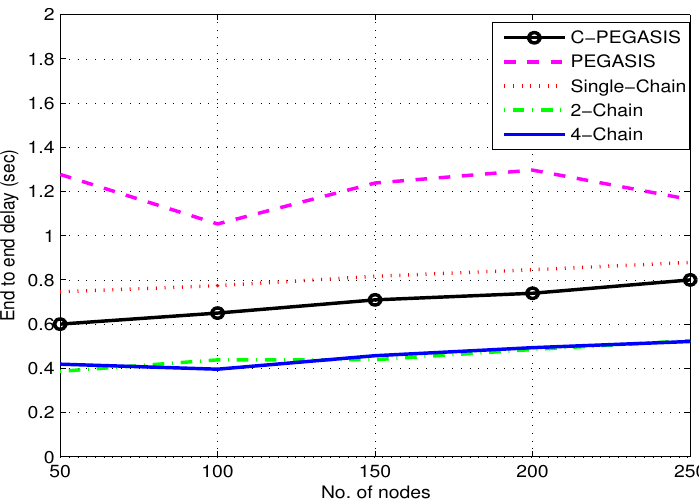
Figure 15. Impact of node density on network lifetime.